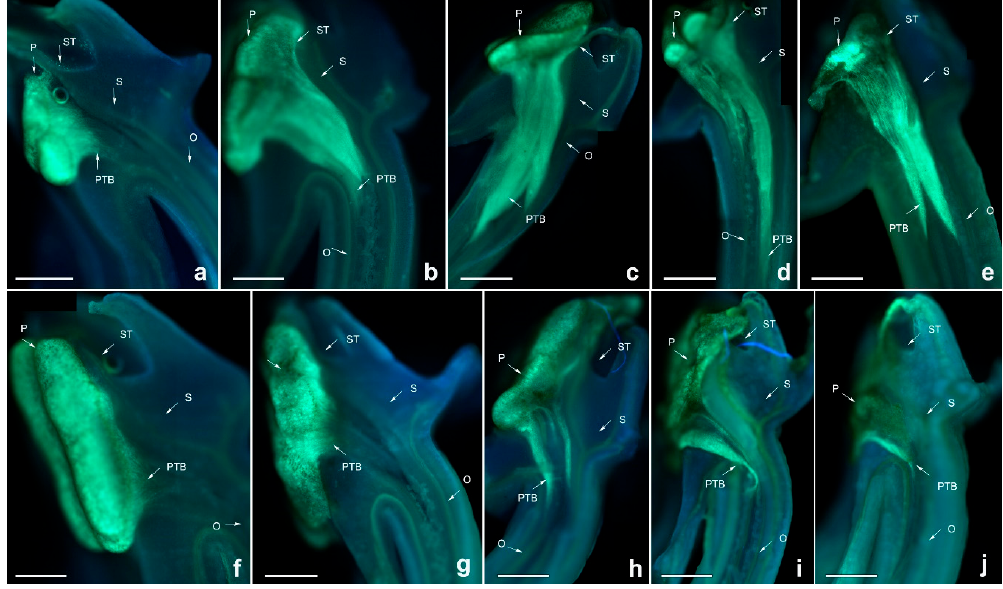
Figure 9. Growth of pollen tubes after self- and cross-pollination of Dendrobium jenkinsii . P: pollinium;